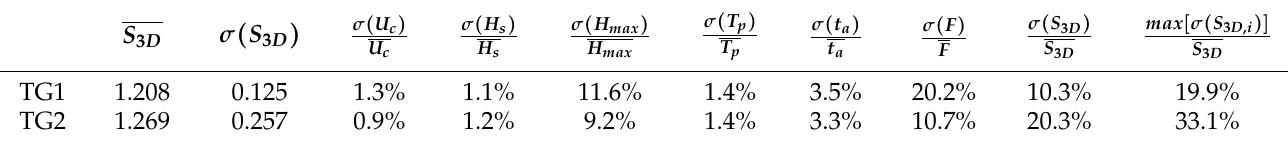
Table 9. Summary of expression of model effects.